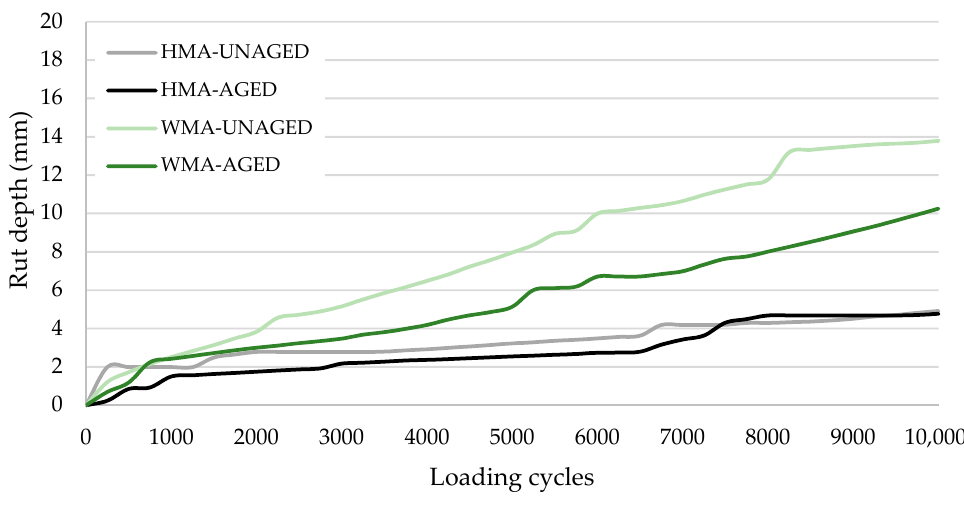
Figure 8. Results of permanent deformation for aged and unaged specimens. Table 5. Wheel tracking test parameters.